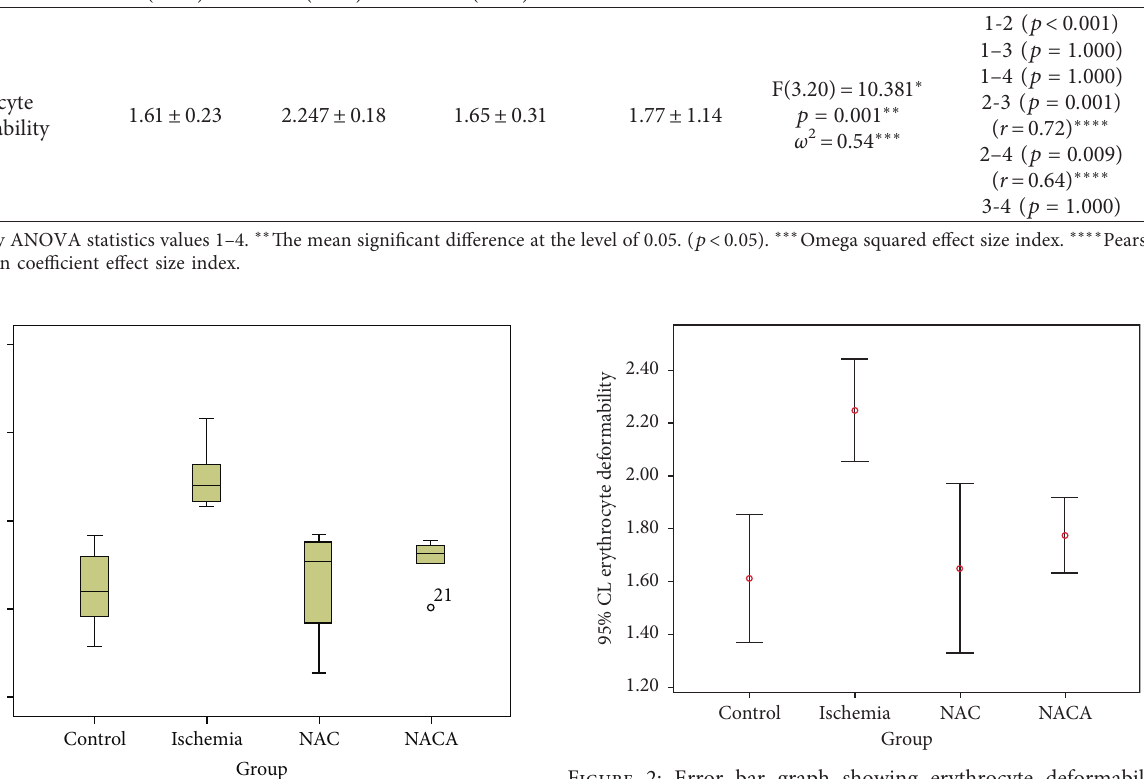
Figure 1: Box plot graph showing erythrocyte deformability dis- tributions in groups.